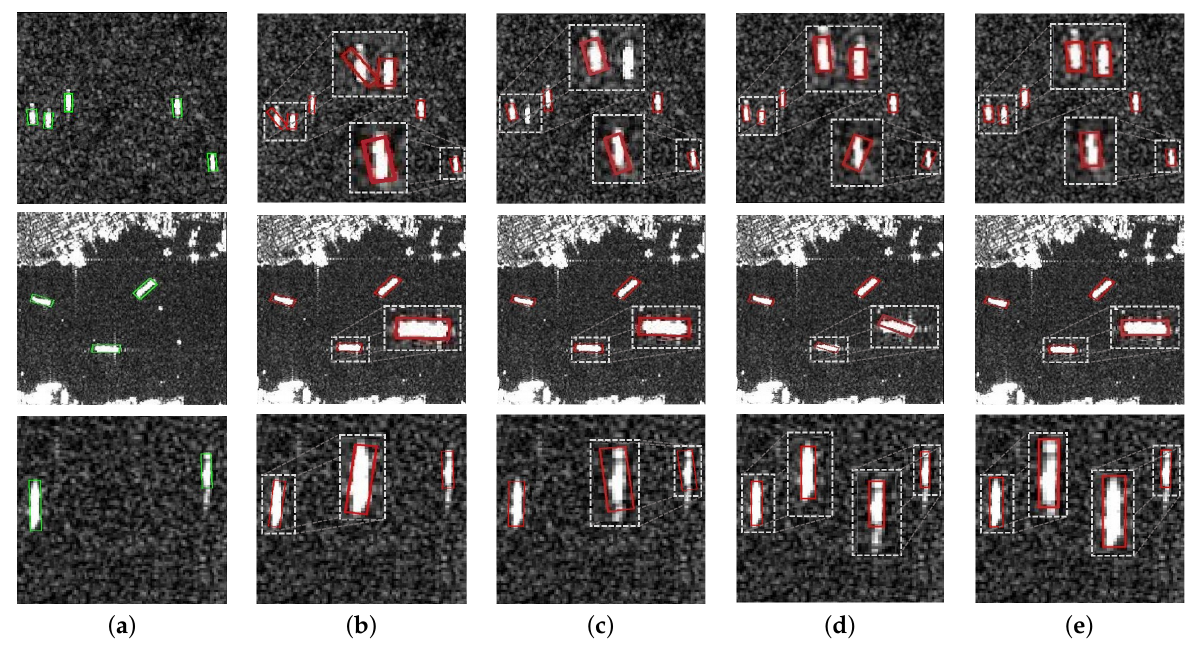
Figure 10. Detection results of the models based on the different encodings for the ships under the boundary cases: ( a ) ground truth; ( b ) OpenCV encoding; ( c ) long-edge encoding; ( d ) BBAVectors encoding; ( e ) our proposed